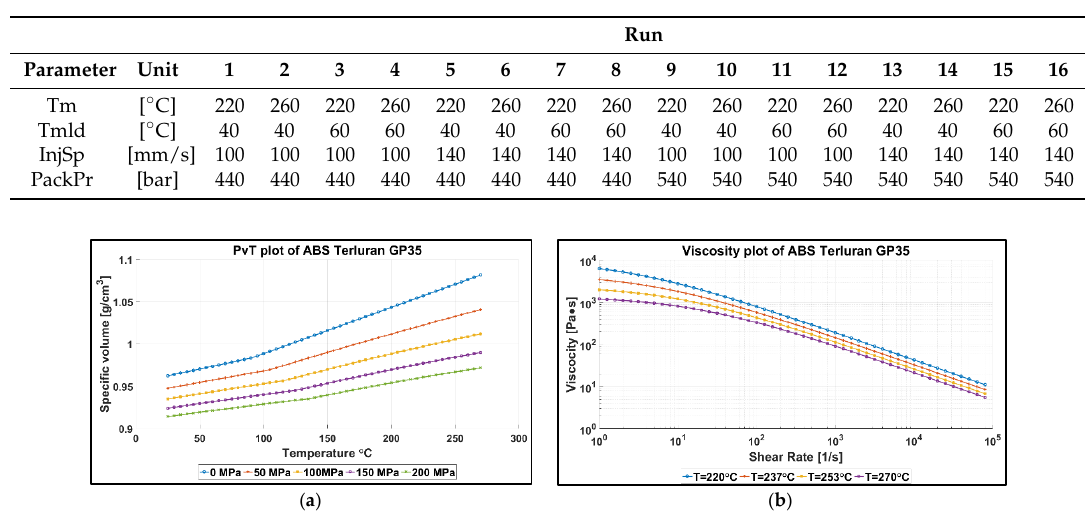
Figure 5. ( a ) PvT and ( b ) viscosity plots of material Styrolution Terluran GP-35 (Acrylonitrile Butadiene Styrene—ABS) [19]. Table 1. Experimental Parameters.